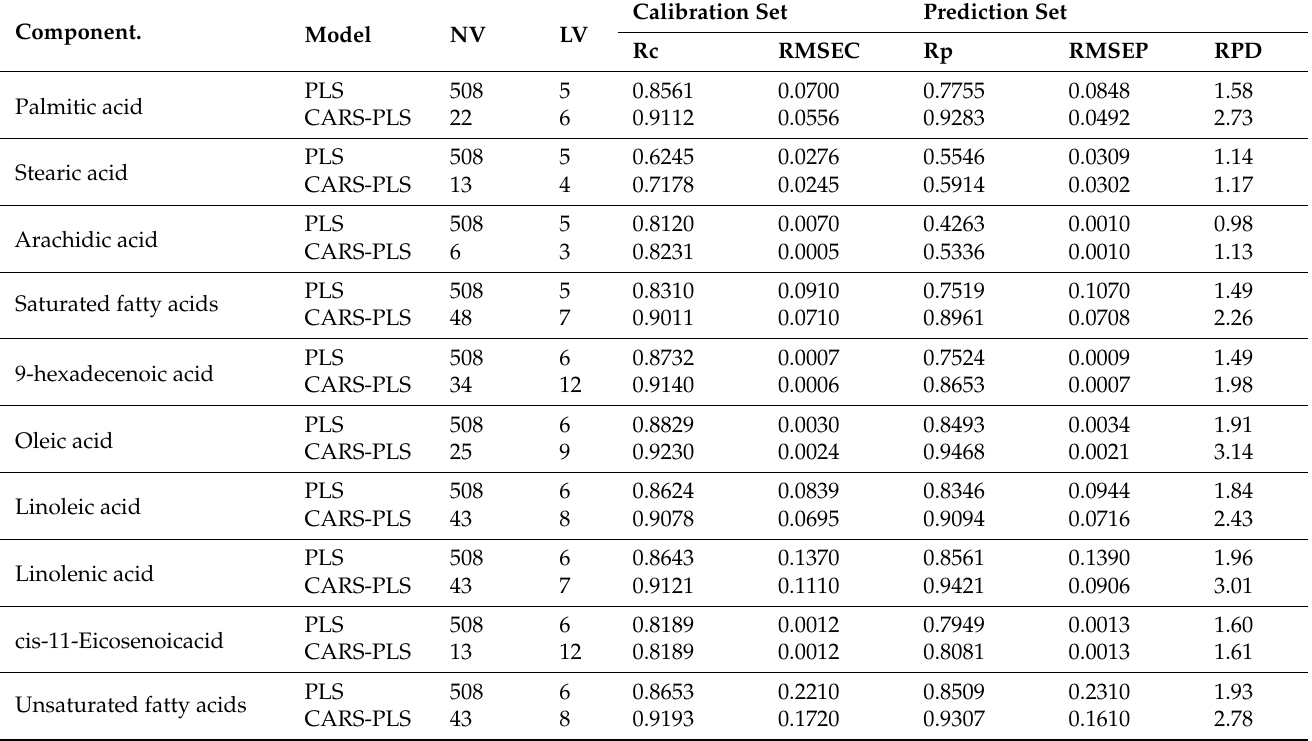
Table 1. Model performance for fatty acid-profile prediction using PLS and CARS-PLS.